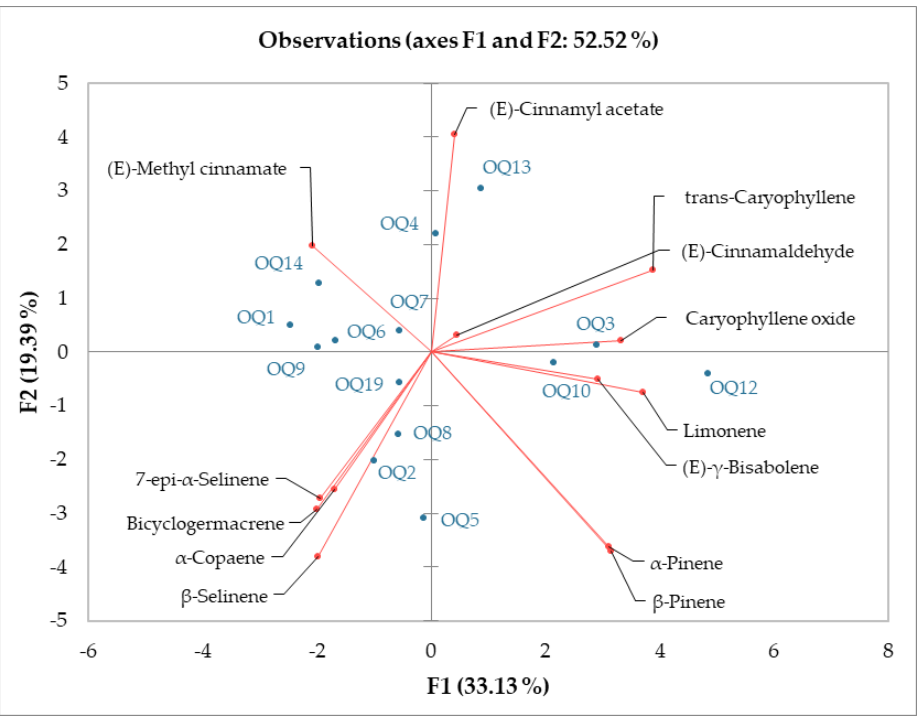
Figure 1. Principal Component Analysis (PCA) of the chemical compositions of the essential oil from ishpingo ( Ocotea quixos ) leaf samples. ishpingo ( Ocotea quixos ) leaf